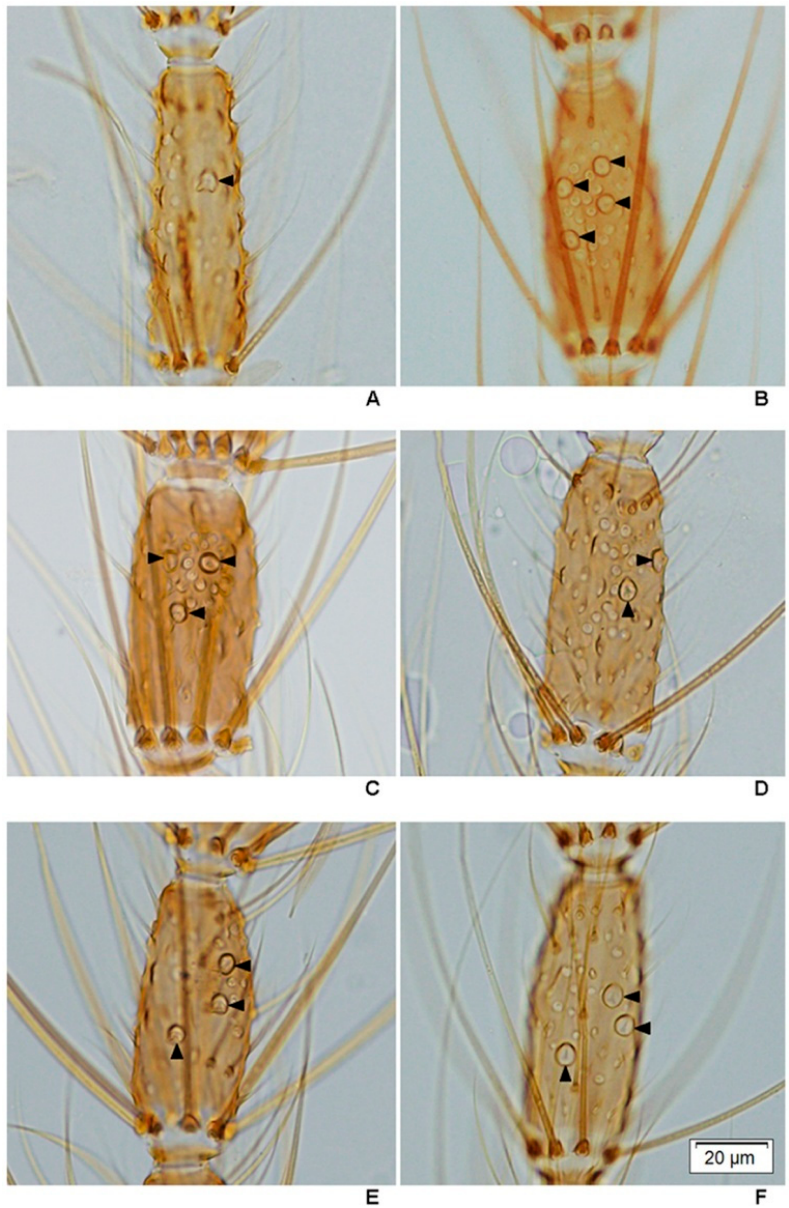
Figure 8. The distribution of large sensilla coeloconica on the 5th antennal flagellomere of six species of the Hyrcanus Group, photographed under a compound microscope: ( A ) An. crawfordi ; ( B ) An. nitidus ; ( C ) An. nigerrimus ; ( D ) An. paraliae ; ( E ) An. pursati ; and ( F ) An. sinensis . Scale bar: 0.02 mm.